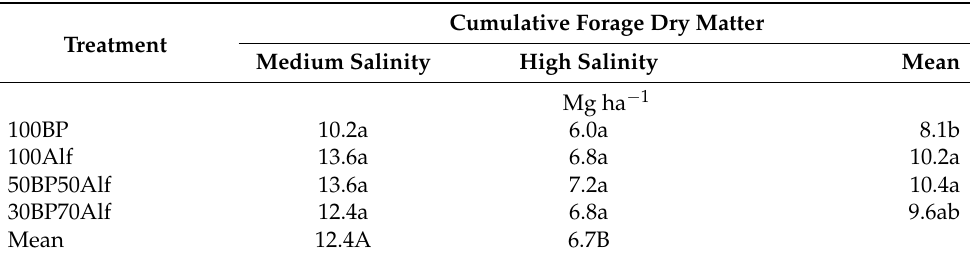
Table 2. Cumulative forage dry biomass of blue panicum (BP) and alfalfa (Alf) monocrops and their 50–50 and 30–70% mixtures in medium and high salinity from June to December 2021.